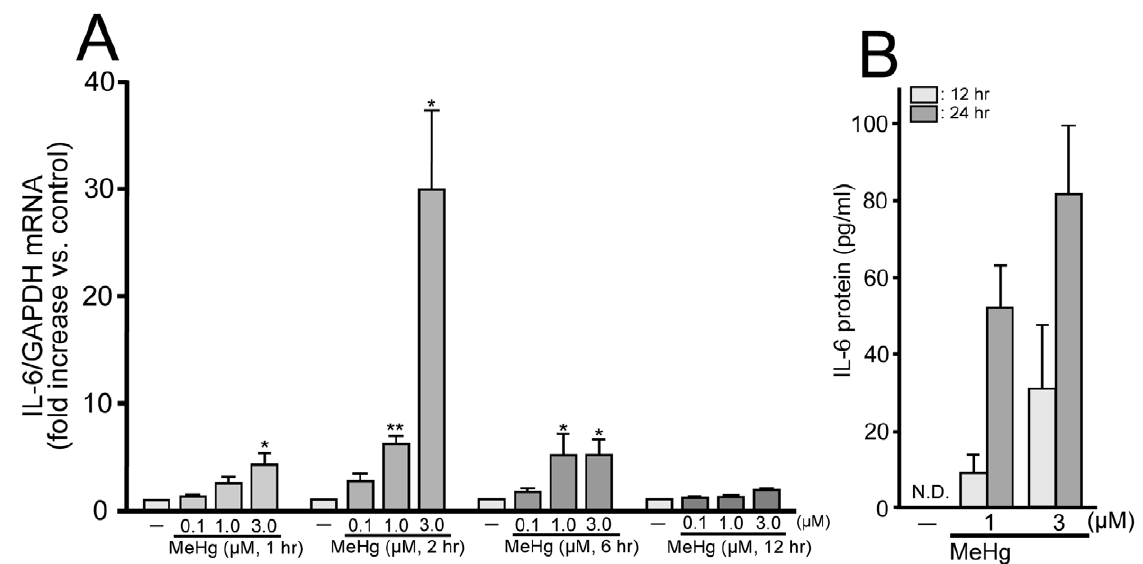
Figure 1. MeHg-induced IL-6 mRNA upregulation and protein release from astrocytes. ( A ) Effect of MeHg on IL-6 mRNA expression in astrocytes. MeHg (1–3 m M) transiently increased IL-6 expression and the induction peak was observed at 2 hr exposure. Low concentration of MeHg (0.1 m M) had no effect on IL-6 expression. *P , 0.05 and **P , 0.01 vs. control. ( B ) MeHg-induced IL-6 protein production to the supernatant from astrocytes. MeHg (1 or 3 m M, 12 or 24 hr) induced IL-6 production. The 12-hr exposure exhibited a lower level of IL-6 release than that with 24-hr exposure of MeHg.